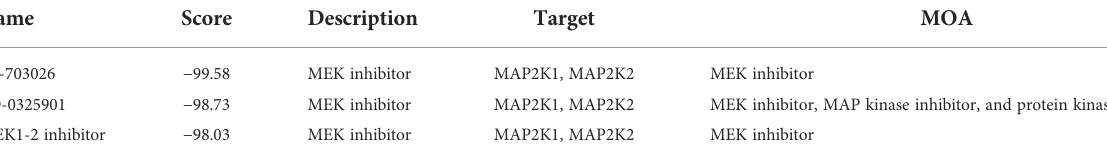
TABLE 3 Three bioactive compounds with one common action mode by CMap